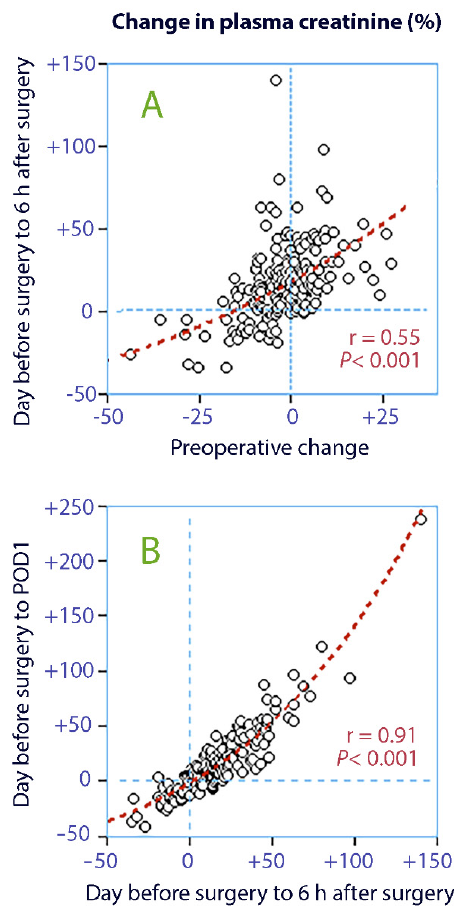
Figure 1. Linear correlations between changes in plasma creatinine; ( A ) the preoperative change vs. the change from the day before surgery to 6 h after surgery; ( B ) the further change to the first postoperative day (POD1).